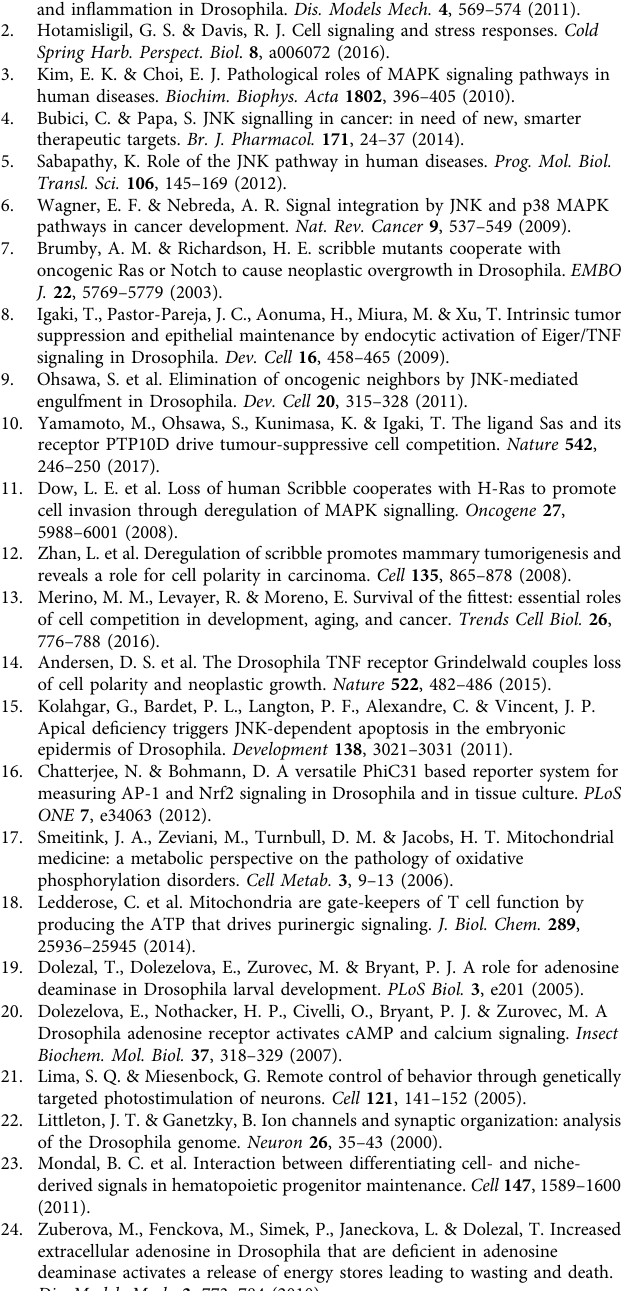
Supplementary Fig. 3a: w 1118 ; sal-Gal4, UAS-cd8GFP, TRE-dsRed(II)/ + ; UAS- GFP/UAS-scrib-RNAi . Supplementary Fig. 3b: w 1118 ; sal-Gal4, UAS-cd8GFP, TRE- dsRed(II)/ + ; UAS-G α S -RNAi/UAS-scrib-RNAi . Supplementary Fig. 3c: w 1118 ; sal- Gal4, UAS-cd8GFP, TRE-dsRed(II)/ + ; UAS-PKAmR*/UAS-scrib-RNAi . Supplementary Fig. 4a, b: w 1118 ; ap-Gal4/UAS-AdoR; Eiger-GFP/UAS-Ent2 . Data availability All relevant data are available from the authors upon reasonable